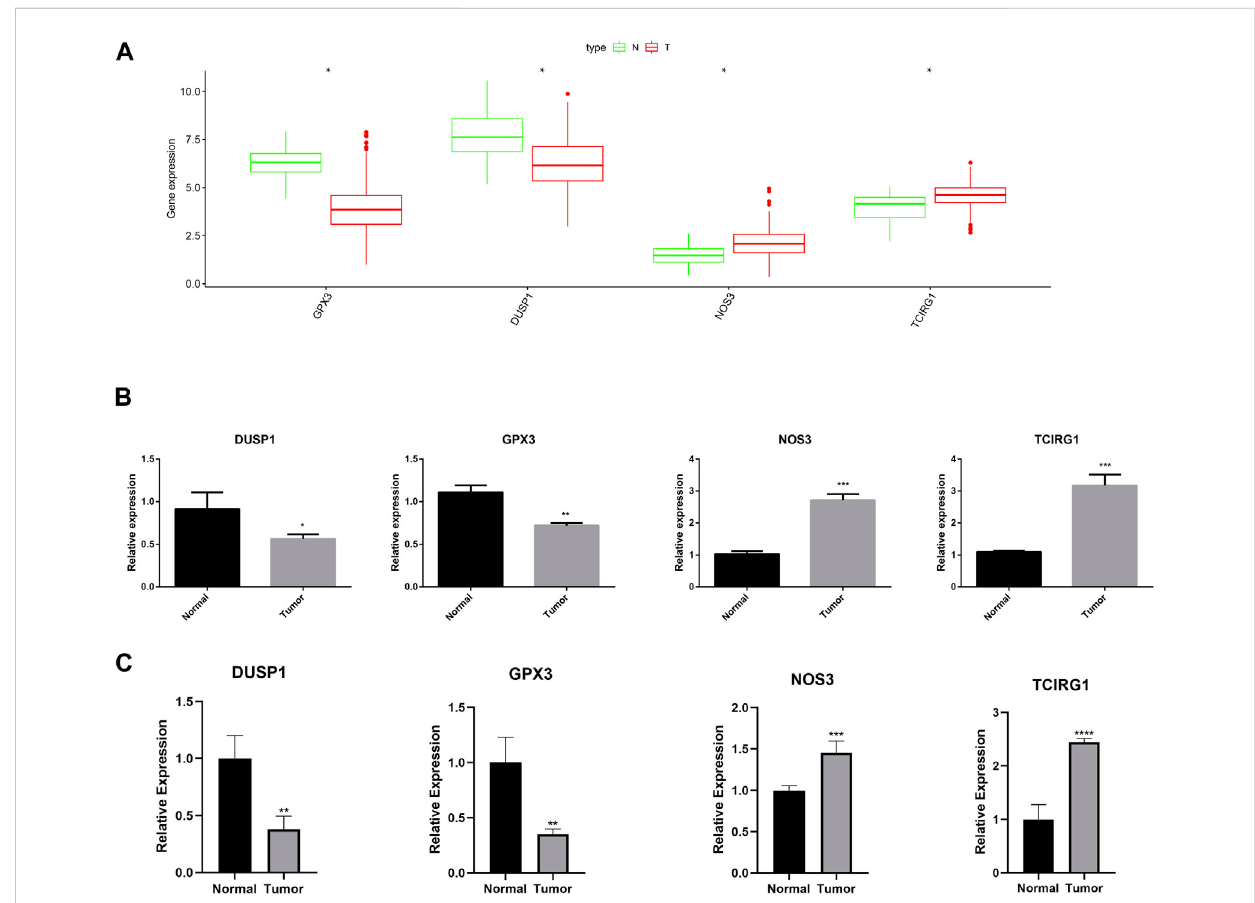
FIGURE 15 Expression of GPX3, DUSP1, NOS3, and TCIRG1. (A) Expression of DUSP1, GPX3, NOS3, and TCIRG1 in GEPIA2 online set. (B) RT-qPCR detected the expression of DUSP1, GPX3, NOS3, and TCIRG1 in gastric cancer cell and normal cell. (C) RT-qPCR detected the expression of DUSP1, GPX3, NOS3, and TCIRG1 in gastric cancer samples and normal